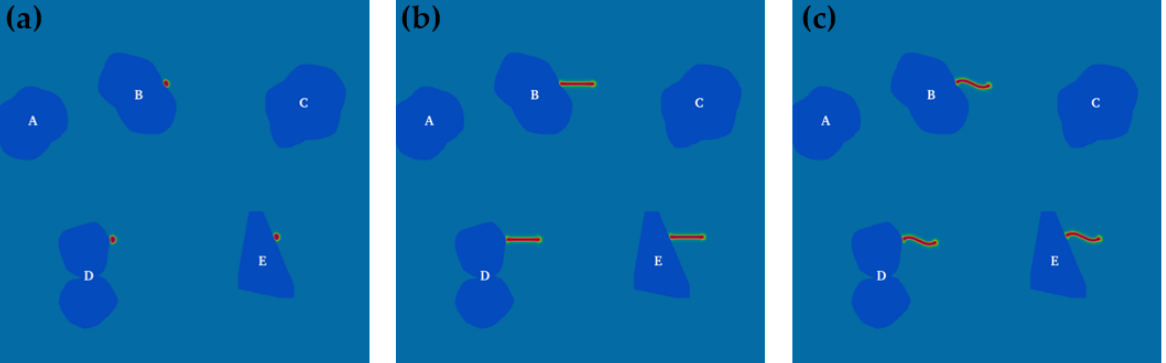
Figure 1. Shape design of the filler and the location of the crystal nuclei. ( a ) Circular crystal nuclei, ( b ) rodlike crystal nuclei, ( c ) curved crystal nuclei.